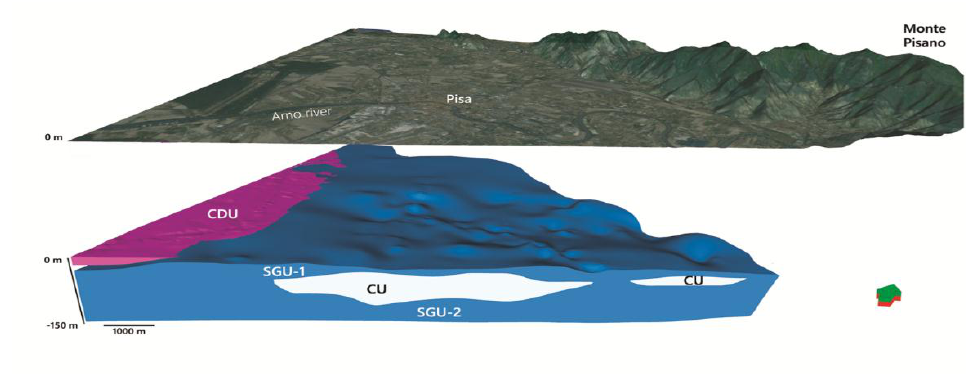
Figure 5. 3D view of the bedrock upper surface (isobaths in m a.s.l) and master faults of the basin. Elaborated by the inversion of gravity data. Coordinate system in meters.